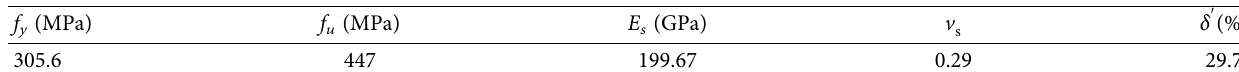
Figure 1: Sizes of specimens (unit: mm): (a) upper end plate, (b) lower end plate, and (c) stifener. Table 2: Properties of steel tube.